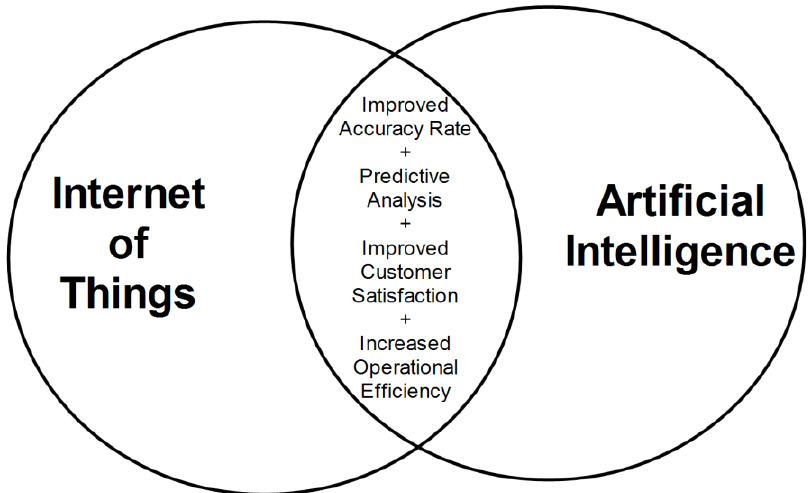
Sensors 2022 , 22 , x FOR PEER REVIEW Figure 9. The common functionality in the IoT and artificial intelligence. Figure 9. The common functionality in the IoT and artificial intelligence.